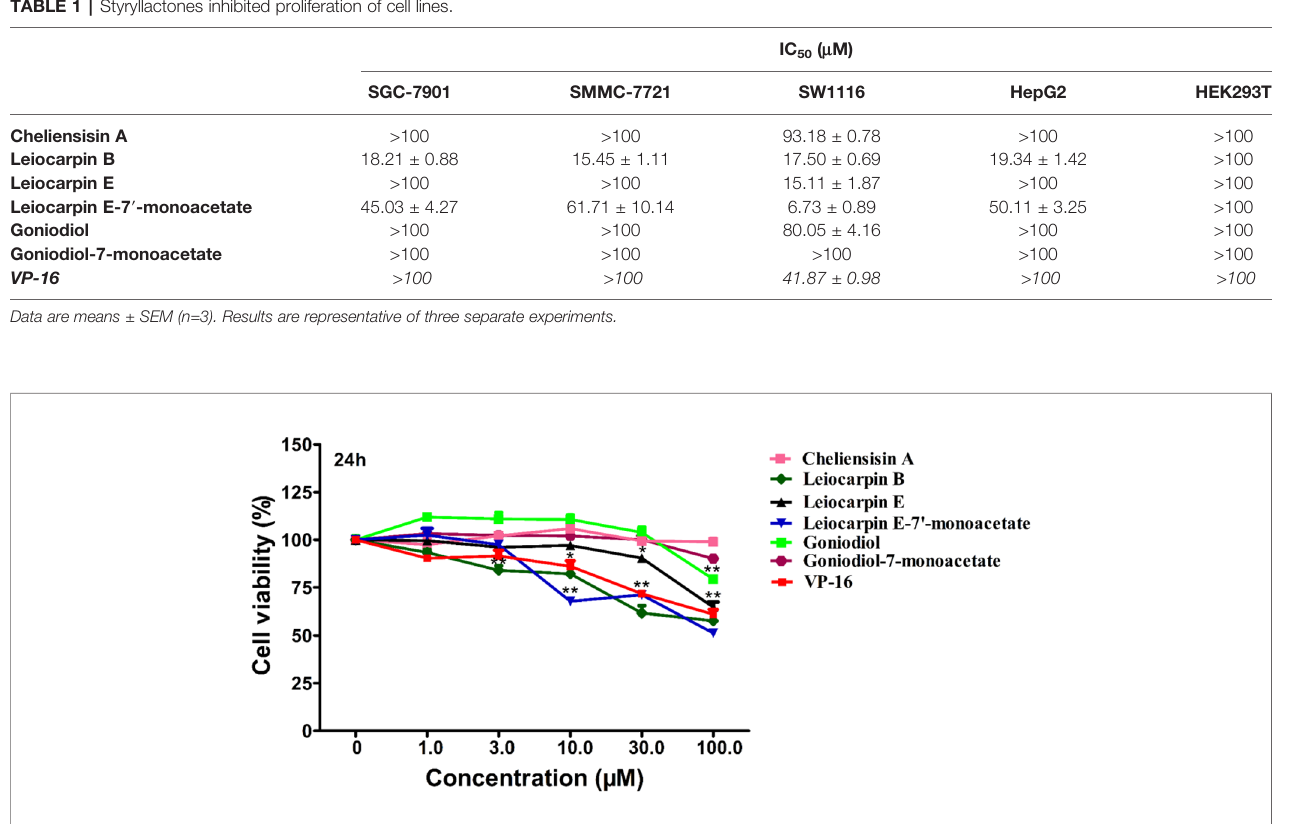
FIGURE 4 | Cytotoxic effect of styryllactones against the human normal cell line human embryonic kidney 293T (HEK293T). The cells (5×10 4 cells/ml) were cultured in the absence or presence of styryllactone compounds (1.0, 3.0, 10.0, 30.0, 100.0 m M) for 24 h. VP-16 (1.0, 3.0, 10.0, 30.0, 100.0 m M) were used as a positive control. Data are means ± standard error of the mean (SEM) ( n =3). Results are representative of three separate experiments. *P < 0.05, **P < 0.01 compared with the group (cell viability in 0 m